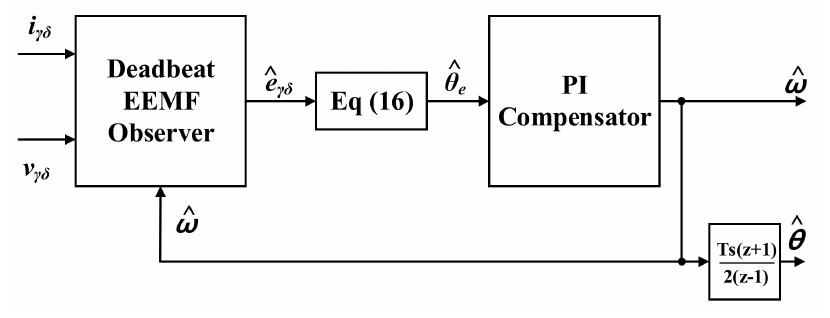
Figure 4. Block diagram of the rotor speed and position estimation